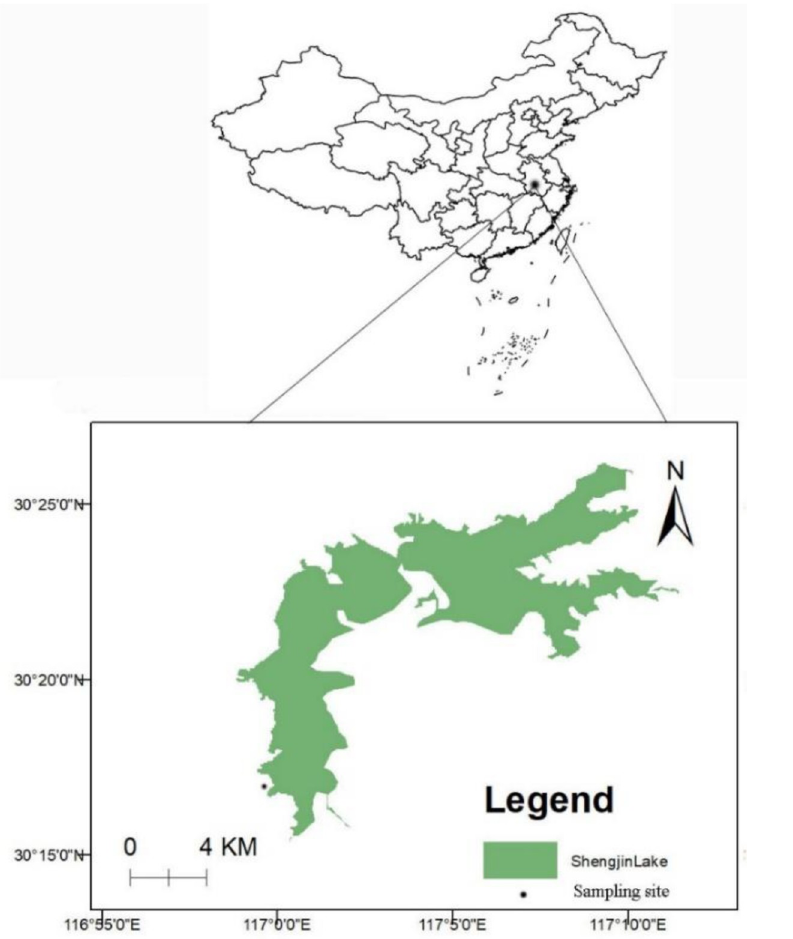
Fig 1. Sampling site geographical